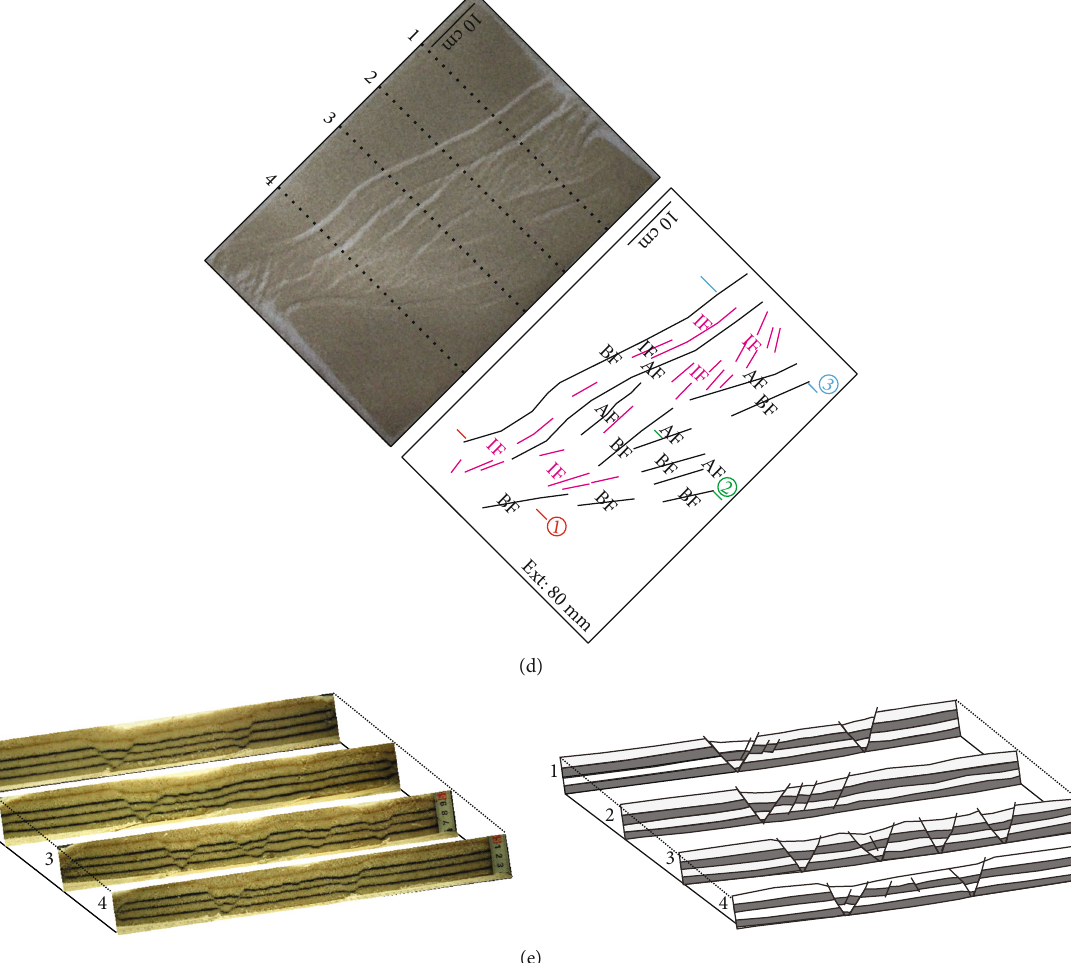
Figure 3: Evolution and characteristics of deformation in reference model 1. (a – d) Top-view photos (left panels) and schematic line- drawings of structures (right panels), illustrating boundary faults (BF), antithetic faults (AF), and internal faults (IF). (e) Vertical cross sections corresponding to locations in